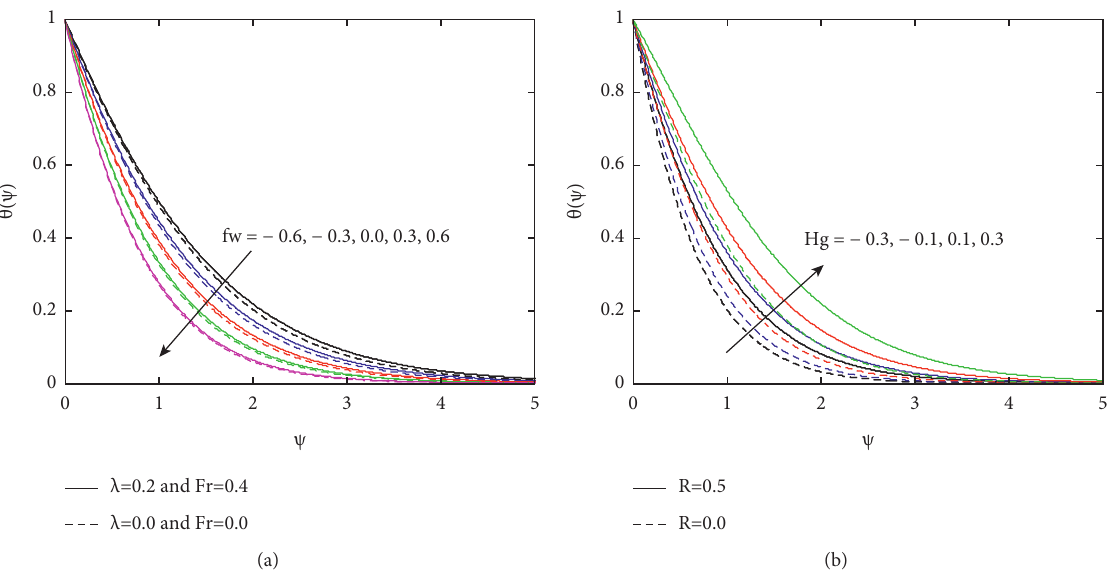
Figure 4: The temperature distribution for diverse quantity of fw (a) and Hg